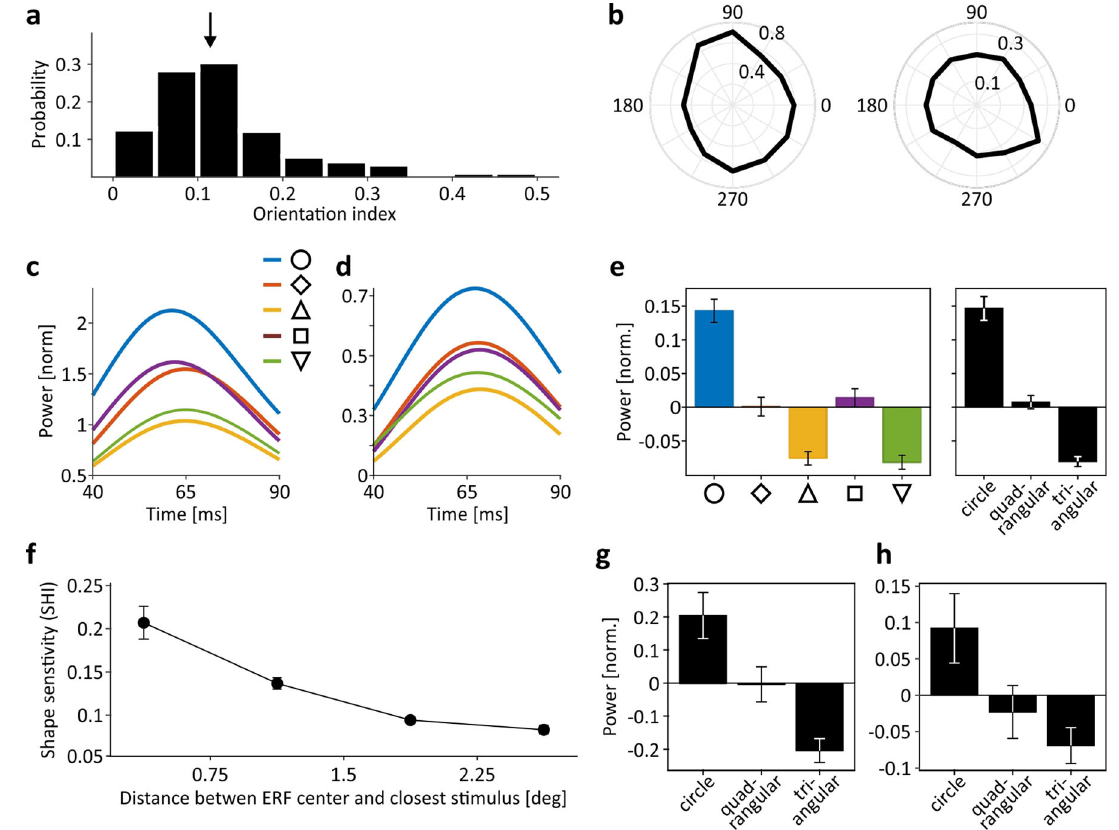
Fig. 5 EFP modulation as function of stimulus orientation and shape. a Distribution of orientation indices from all channels with signi fi cant orientation bias ( N = 235). Arrow indicates median (OI = 0.115). b Two example electrodes exhibiting orientation bias close to median (left) and close to max (right) OI . Numbers on horizontal and vertical axes, stimulus orientation; numbers within polar plots, normalized response strength. c – d Time course of responses to different shape conditions of an example channel with full overlap between ERF and stimulus area ( c ) and another channel with no overlap ( d ). Channels are the same as shown in Fig. 4a, c. e Averaged responses over all channels to each of the fi ve shape conditions (left) and after merging conditions with identical angularity (right). f Averaged shape sensitivity as function of center-to-center distance between ERF and closest stimulus. g – h Averaged response strength to circular, quadrangular, and triangular stimuli at electrodes with ERF centers < 0.75-degree distance ( g ) and between 2.25 and 3-degree distance ( h ) from stimulus center. Individual data points for the line and bar graphs in ( e – h ) are shown in Supplementary Fig. 2. Error bars indicate SEM